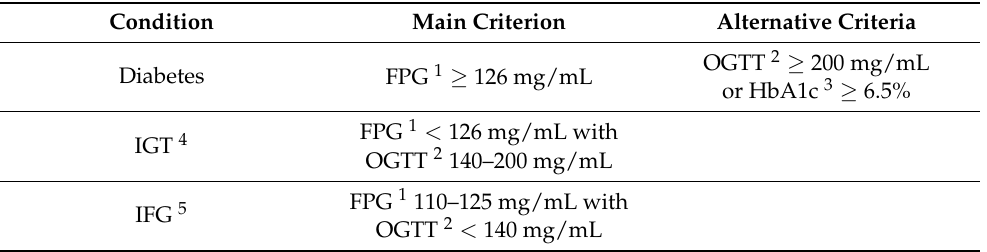
Table 1. Threshold levels for the diagnosis of diabetes or pre-diabetes according to the International Diabetes